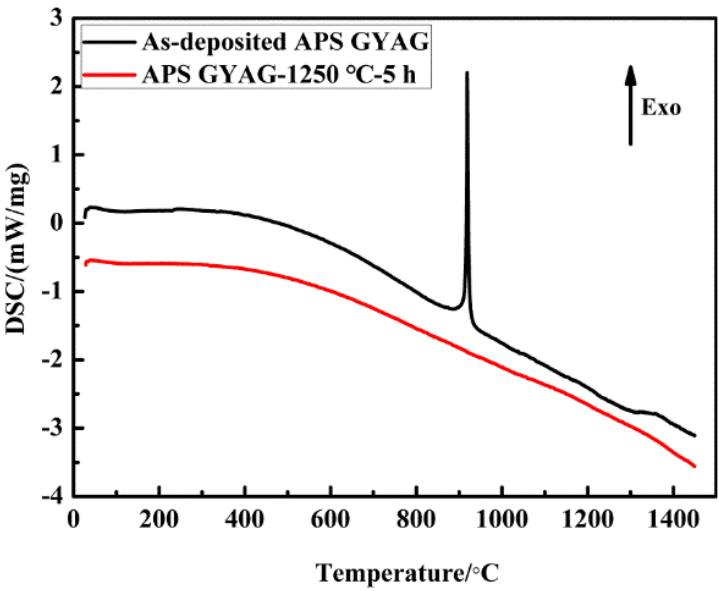
Figure 6. DSC curves of GYAG coatings before and after heat treatment.